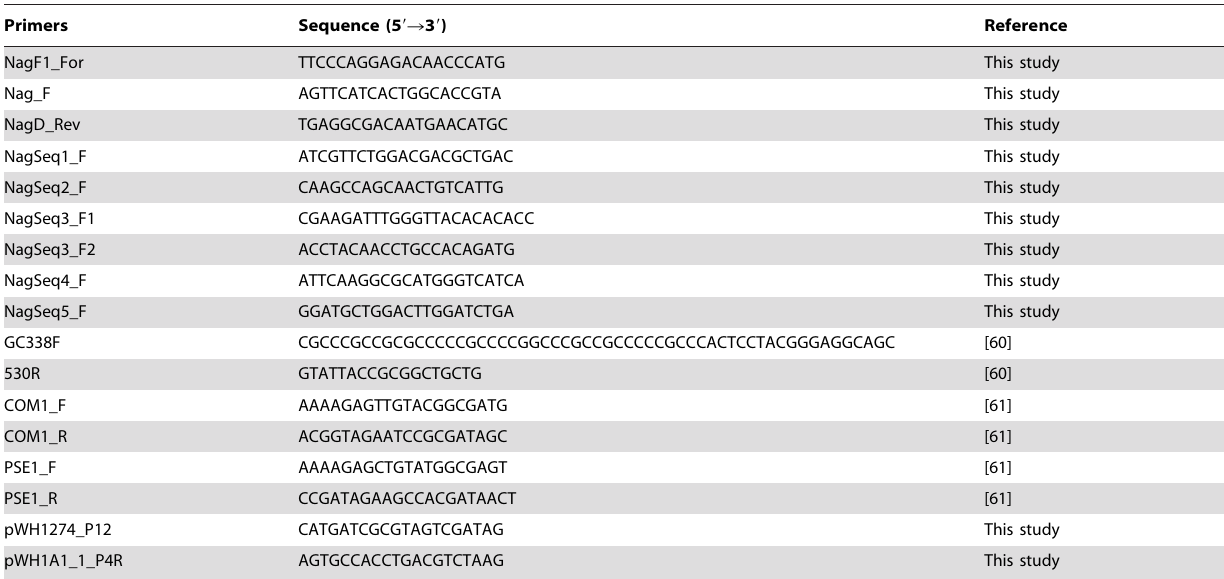
Table 1. Primers used in this study.